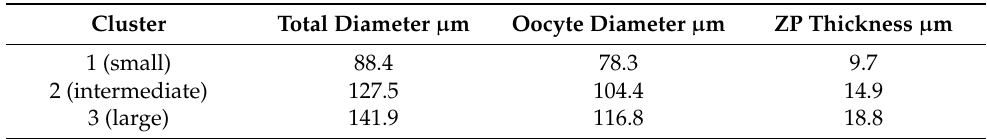
Table 3. Mean values of morphometric parameters of oocyte size in each generated cluster for total diameter, oocyte diameter, and ZP